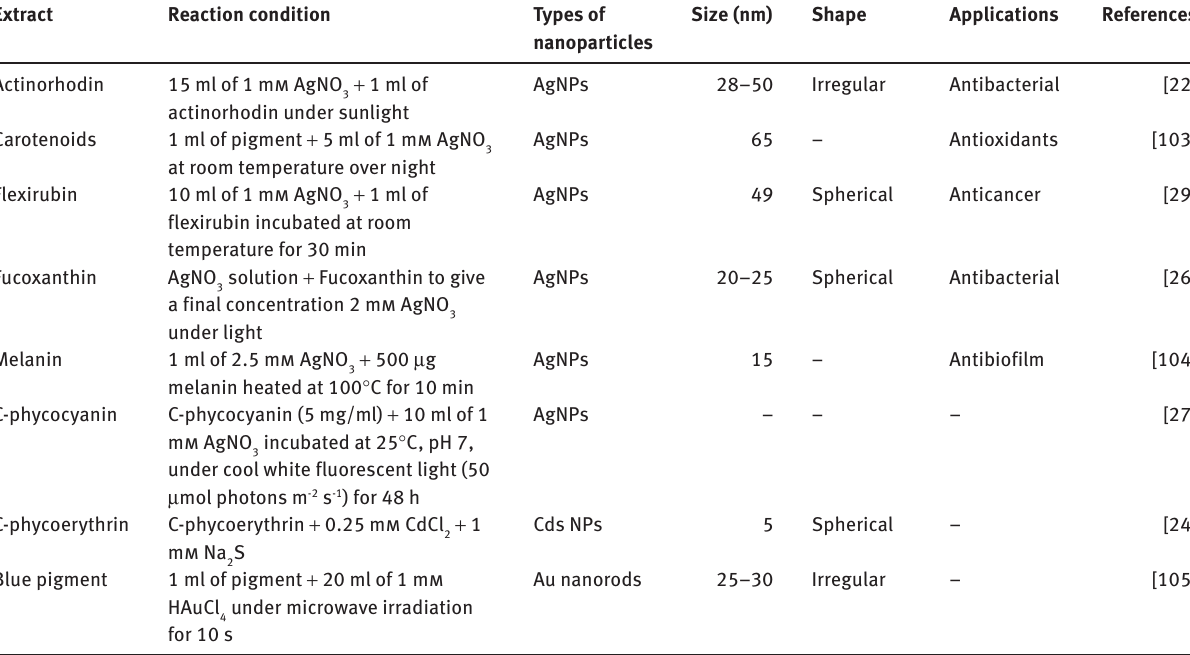
Table 3: Synthesis of nanoparticles by pigments. Extract Reaction